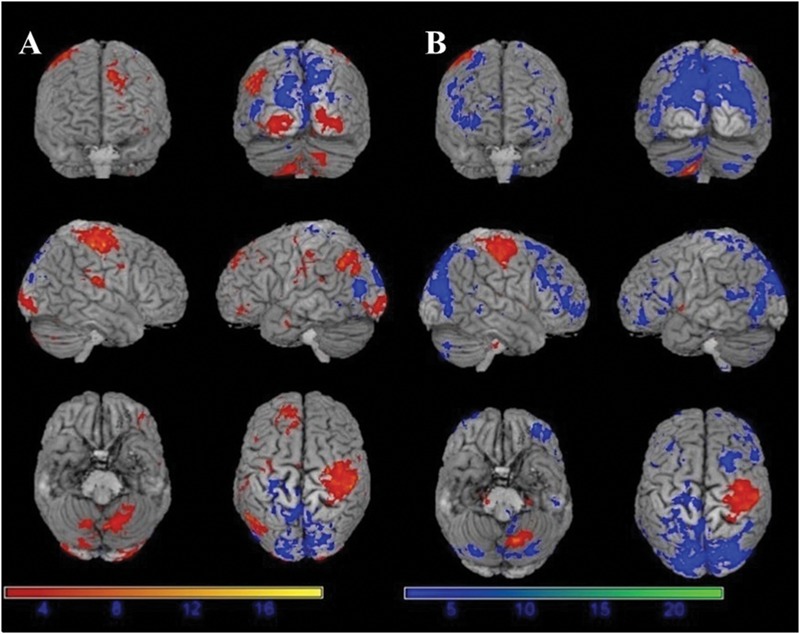
Significant activation (red) and deactivation (blue) volumes when subjects are performing hand movement before (A) and during (B) motor fatigue. Color bar: t-values.